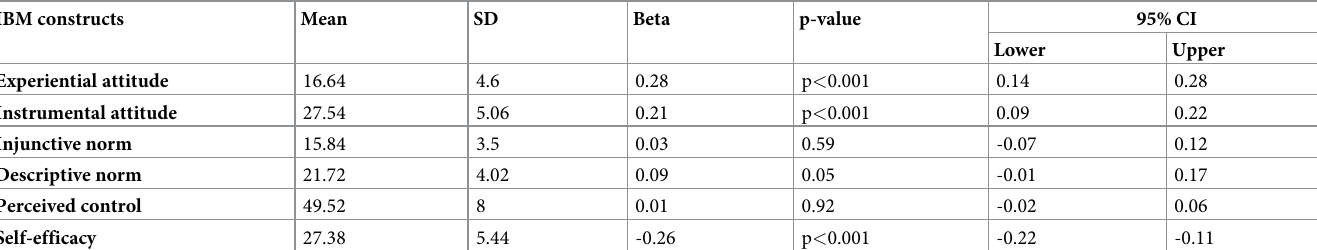
Table 3. Behavioral intention and its association with constructs of IBM among participants.